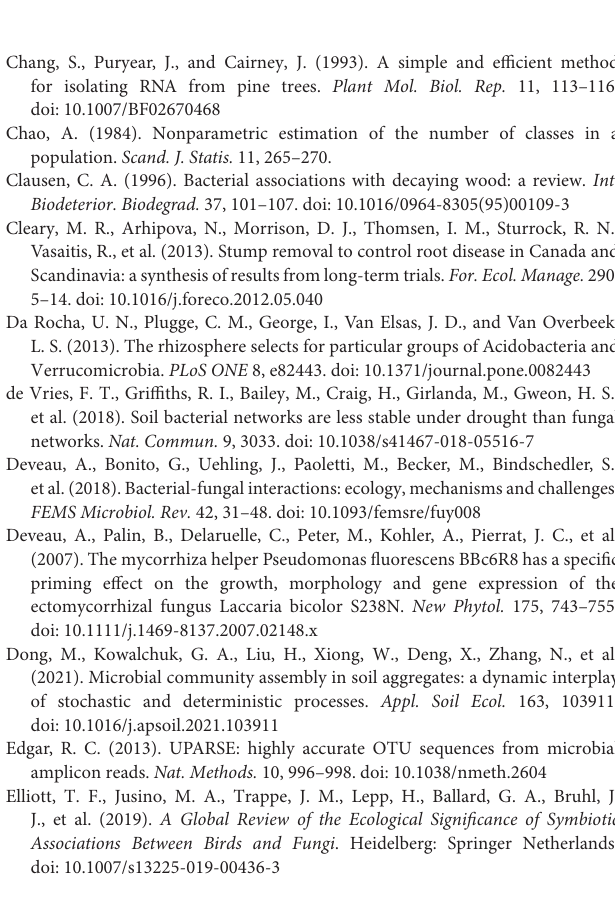
Supplementary Figure 1 | Rarefaction curve of study groups showing the sequence depth. Supplementary Figure 2 | PCoA analysis of bacterial communities in four decay stages in fruiting body. Supplementary Figure 3 | PCoA analysis of bacterial communities in four decay stages in wood tissue. Supplementary Figure 4 | Co-occurrence networks of Firmicutes from top 252 OTUs in fruiting body and wood over decay. Supplementary Table 1 | The basic information of each sampling point. Supplementary Table 2 | The relative abundance of functional groups. Supplementary Table 3 | The basic information of OTUs Node in the networks. Supplementary Table 4 | The basic information of co-occurrence edge in